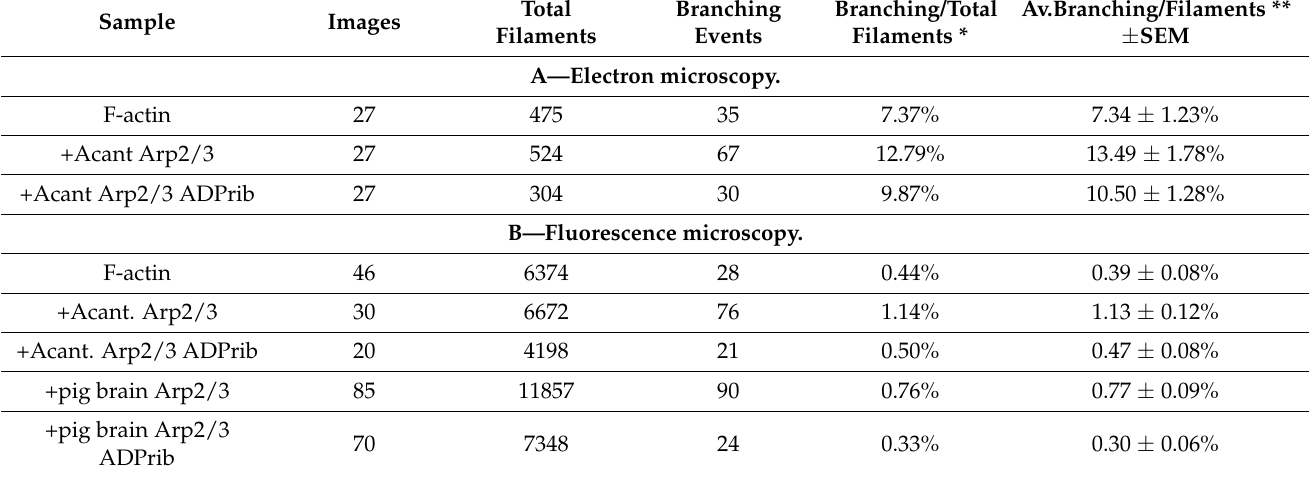
Table 1. Statistical evaluation of F-actin branching events visualized by EM or after TRITC-phalloidin by fluorescence microscopy (LM). (A) Non-overlapping electron microscopical images of skeletal muscle F-actin alone or after incubation with Acamthamoeba Arp2/3 complex before or after ADP- ribosylation (27 images of each condition) were visually evaluated for branching events. The number of filaments and branching events were manually counted for all images (see also Figure 4B–E). (B) Determination of branching events after staining with TRITC-phalloidin of F-actin alone or plus Acanthamoeba or porcine brain Arp2/3 complex before and after ADP-ribosylation. The number of total filaments and the branching events in each selected image were determined by ImageJ ridge detection (Figure 4G–K). Details of the procedure of filament counting and their statistical evaluation by ImageJ are given in the Material and Methods. The branching events are given as percentages of the total filaments or as events occurring for each single filament (giving also the standard error of the mean; SEM). Note the reduction of branching events in the presence of ADP-ribosylated Arp2/3 complex to the value of F-actin alone. The percental difference in branching events observed between EM and FM are probably due to the difference in the concentrations of the F-actins: For EM the F-actin subunit concentration was 2.35 µ M and for fluorescence microscopy (FM) it was reduced to 10 nM, because at higher concentrations the filaments were too numerous and crowded to distinguish between crossing and